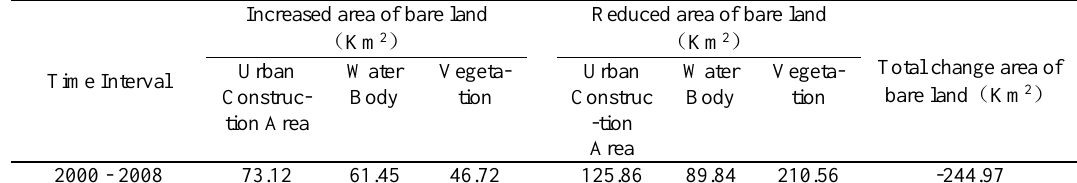
Table 13 Bare land area change from the year 2000 to